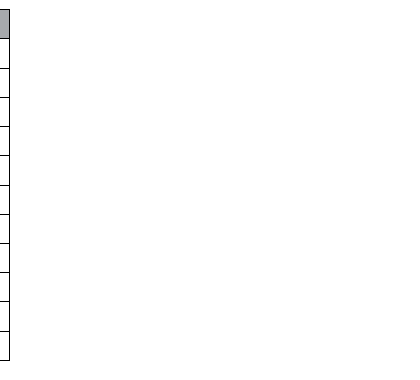
Table 1. Probability of ECM failure and mean time-to-fail (MTTF) of Sn at various Br − concentrations. Standard errors were calculated from the total number of failures during